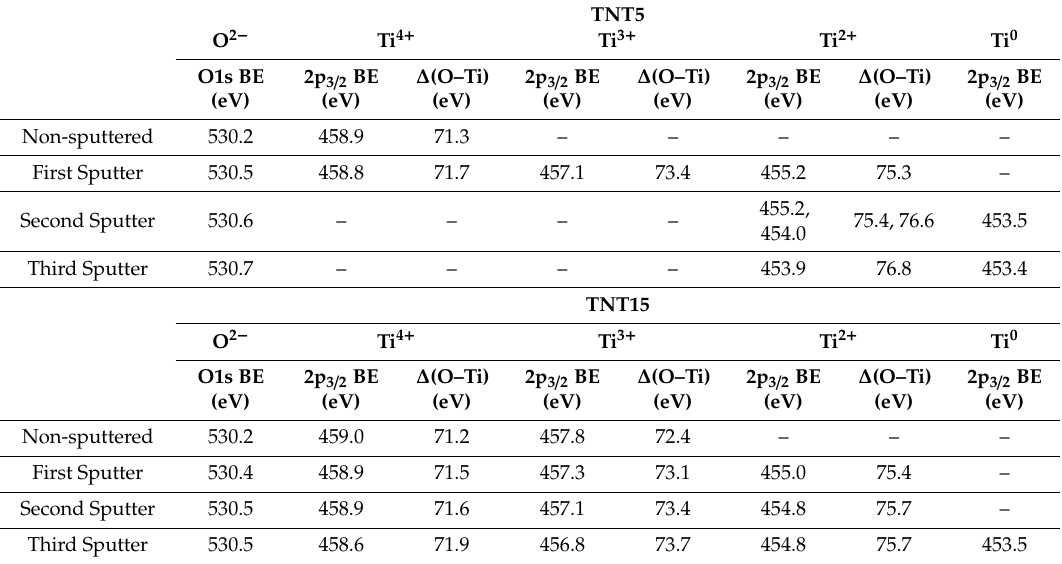
Table 1. Changes in the position of O1s and Ti2p core levels in TNT5 and TNT15 coatings (BE, binding energy) and values of the spectral energy di ff erences between oxygen bonded to Ti 2 + , Ti 3 + , and Ti 4 + ions ( ∆ (O–Ti) = O1s–Ti2p 3 / 2 ) during Ar + sputtering.